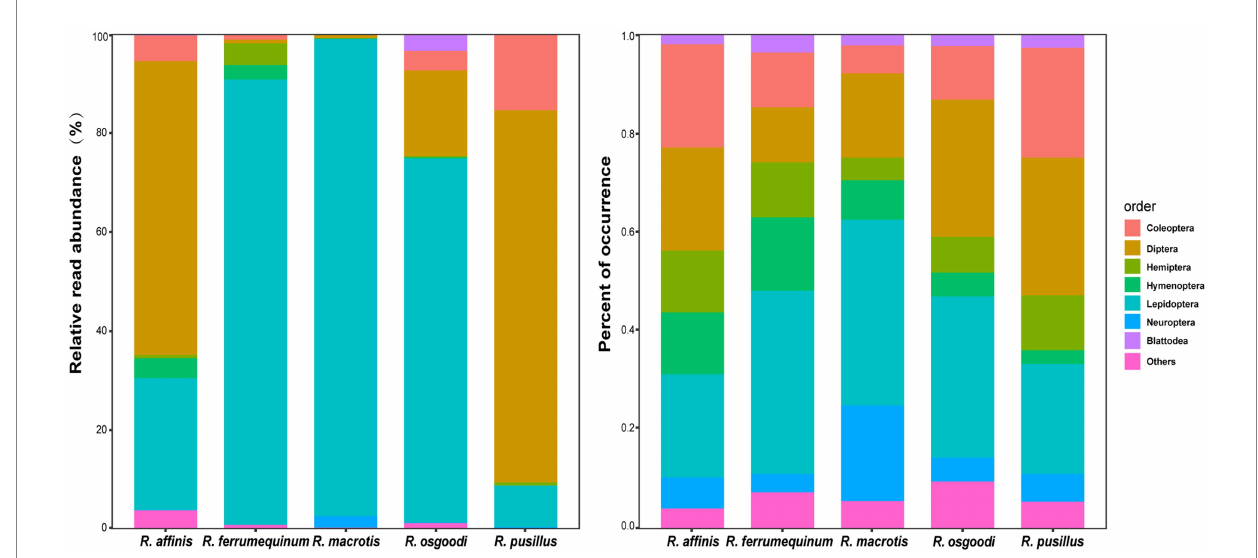
FIGURE 2 Relative read abundance (RRA) and percent of occurrence (POO) of diet composition at the order level in five rhinolophid bats.